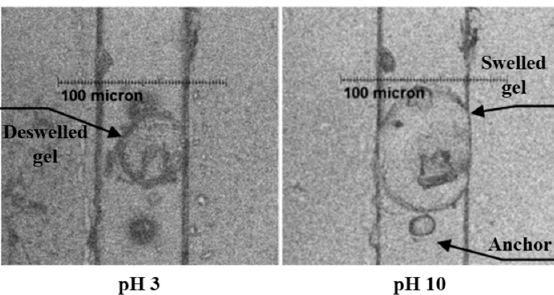
Figure 15. SEM of pH-sensitive microvalve [94].